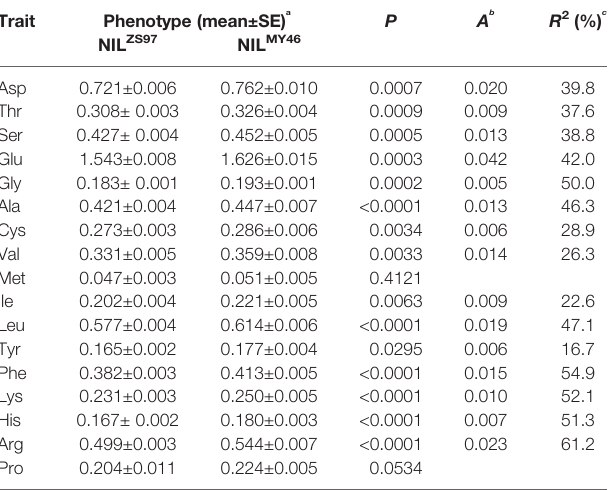
TABLE 5 | Effects of RFT1 ZS9 7 transgene on 17 components of amino acid content (AAC).